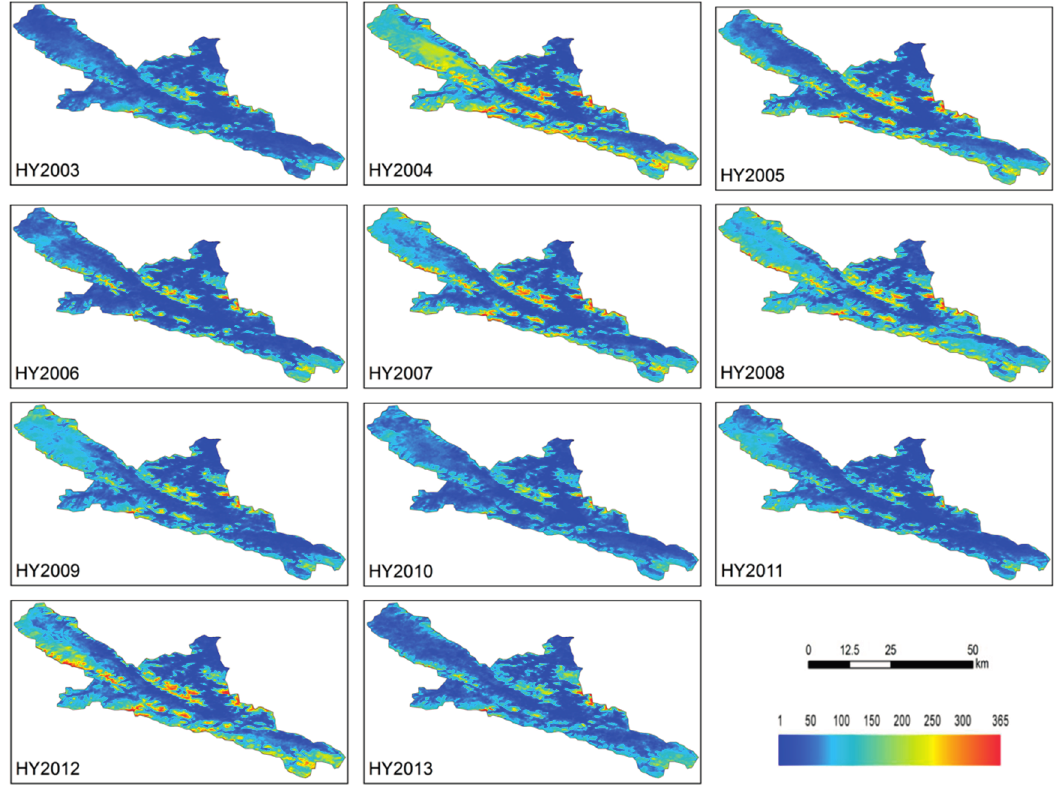
Figure 5. Spatial distribution of snow cover days (SCD) in the upper HRB during HY2003–HY2013. The SCD values range from 0 (blue) to 365 (red)